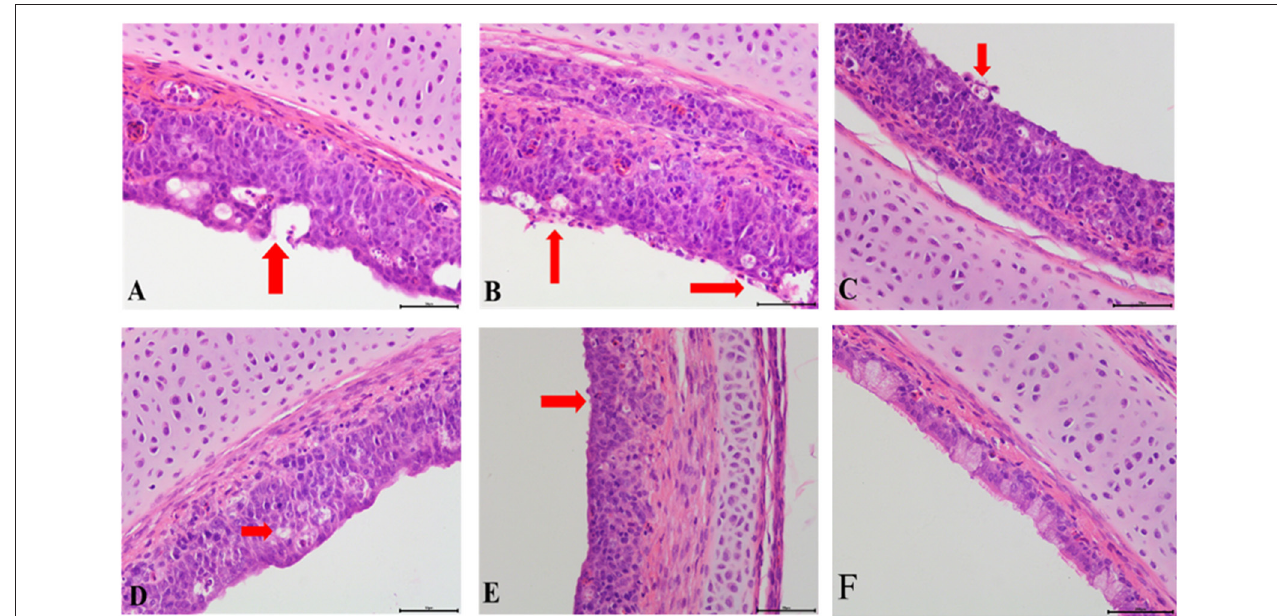
FIGURE 3 | Tracheal histopathology at 5 dpi. (A) IBV/H9N2 group, (B) IBV + H9N2 group, (C) H9N2/IBV group, (D) IBV group, (E) H9N2 group, and (F) Control group. Red arrows point to the lesion. Magnification 400 × , scalebar 50 µ M. IBV, infectious bronchitis virus.